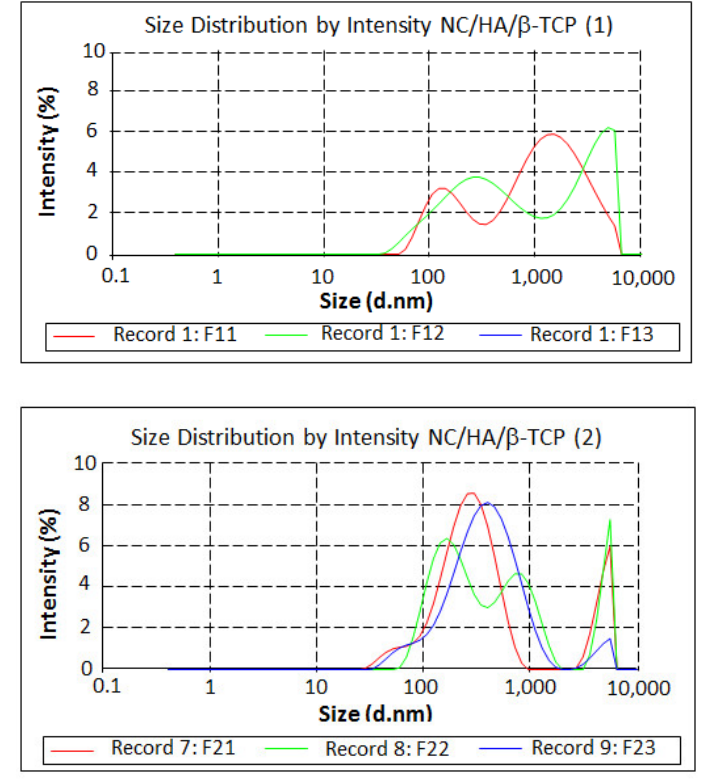
Figure 9. Size distributions of NC/HA/ β -TCP (immediately after hydrolysis), NC/HA/ β -TCP (1) (30 days of hydrolysis), and NC/HA/ β -TCP (2) (60 days of hydrolysis). The particle size results are in the gauge dimension, with a range of 164.2 × 10 −9 –4748 × 10 −9 m, and they are related to the zeta potential results, which have an unstable range of −11 ± 23.8 mV with